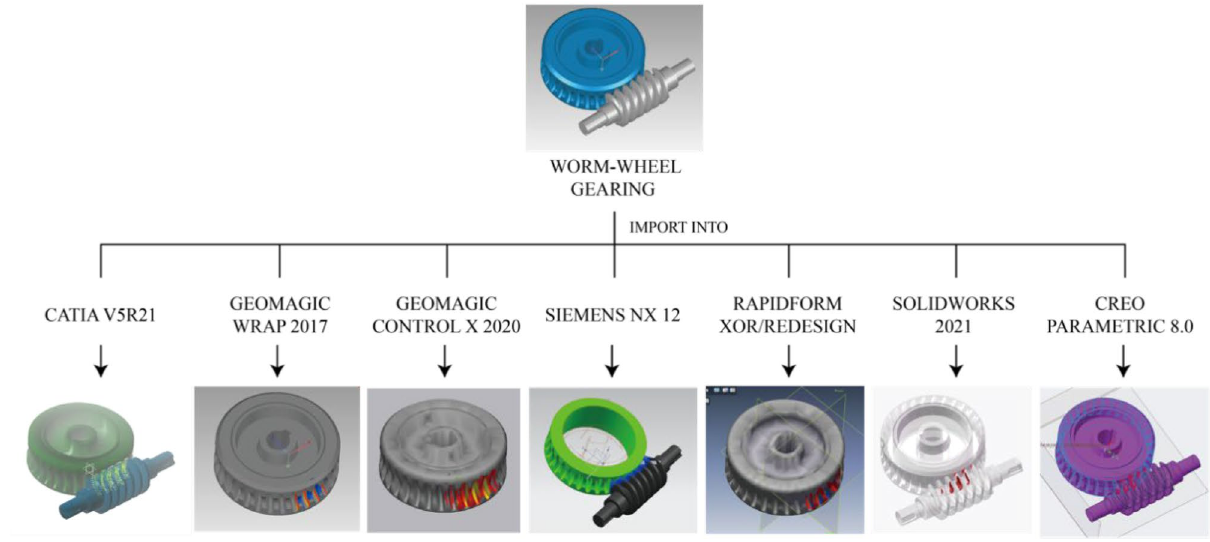
Figure 1. Deviation analysis effect between worm-wheel gearing calculated by seven commercial CAD tools (CATIAV5R21, Geomagic Wrap 2017, Geomagic Control X 2020, Siemens NX 12, Rapidform XOR/Redesign, Solidworks 2019, Creo Parametric 8.0).